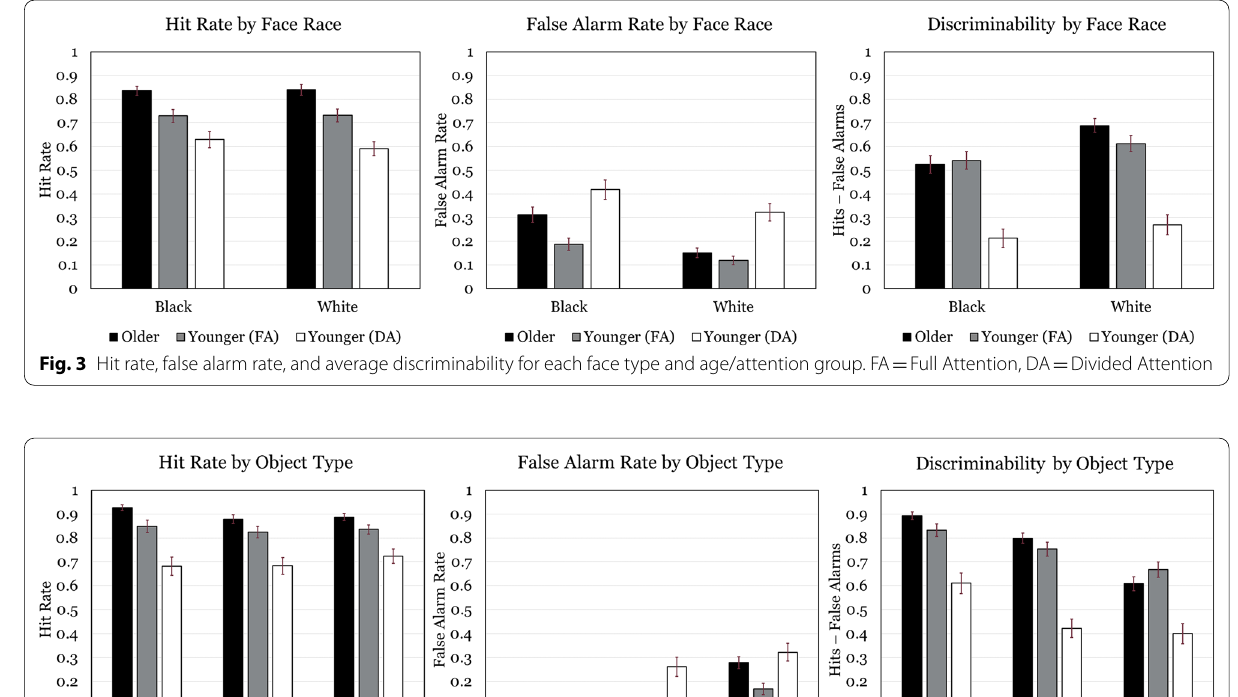
Full Attention, DA Divided = =